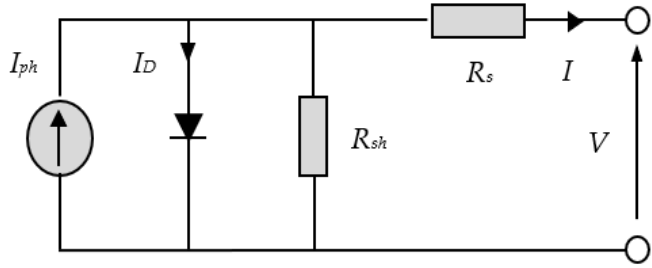
Figure 2. Equivalent circuit of one diode model of the PV cell.